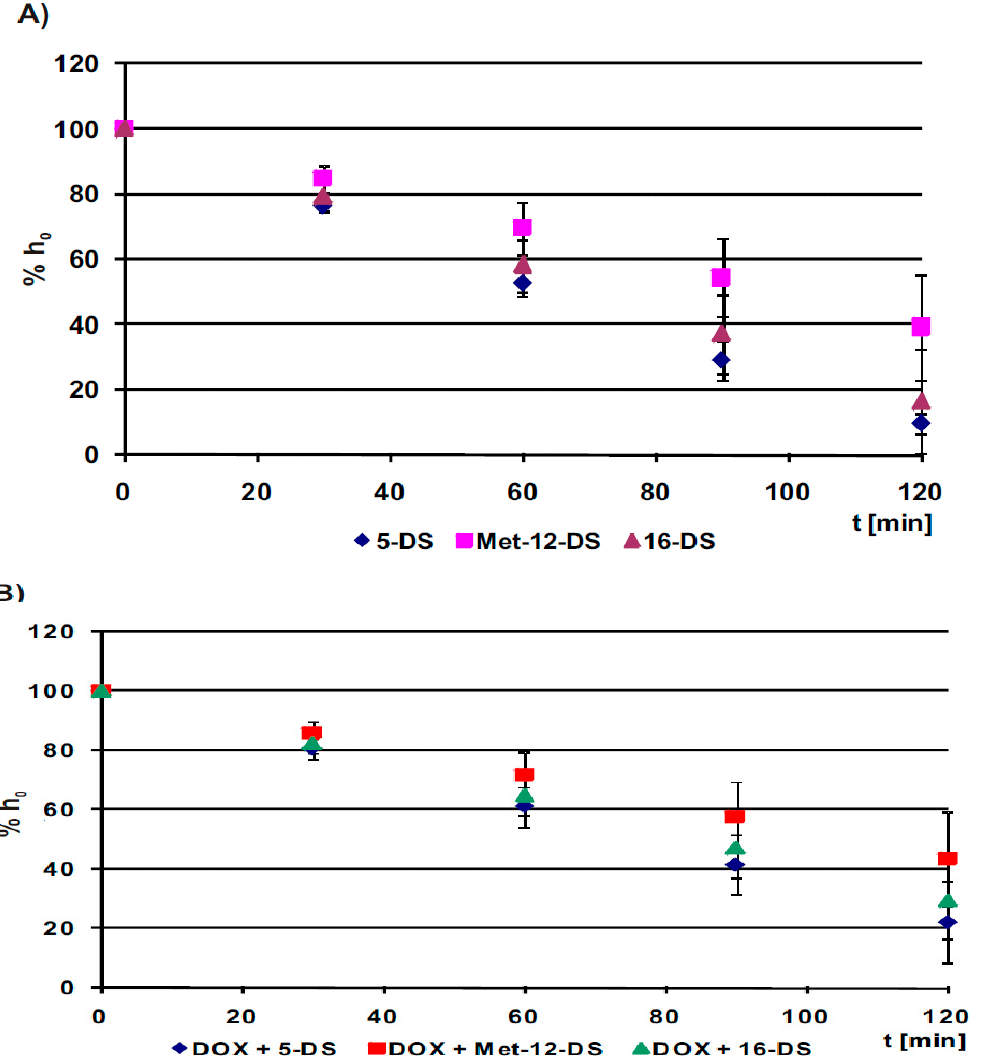
Figure 7. Kinetics of the reduction by B14 fibroblast cells of the doxyl stearate nitroxides (DSs): 5-DS, Met-12-DS, and 16-DS. The data are shown as a percentage of the height of the middle-field line (h 0 ), calculated based on the spectra of the DSs obtained from EPR measurements (Section 4.2.6, Equation (2)). All the data are shown as a mean ± SD of at least three independent experiments. ( A ) Reduction by B14 cells of 5-DS, Met-12-DS, and 16-DS applied alone at 80 µ M final concentration. ( B ) Reduction by B14 cells of 5-DS, Met-12-DS, and 16-DS applied at 80 µ M final concentration together with 1 µ M doxorubicin (DOX). Table 1. ( A ) The rates of reduction (k) in B14 cells of the doxyl stearate nitroxides (5-DS, Met-12-DS, and 16-DS) applied alone at the final concentration of 80 μ M or together with 1 μ M doxorubicin (DOX). The data are presented as means ± SD of at least three independent experiments. ( B ) Half-reduction times in B14 cells of the doxyl stearate nitroxides (5-DS, Met-12-DS, and 16-DS) applied alone at the final concentration of 80 μ M or together with 1 μ M doxorubicin (DOX). The data are presented as means ± SD of at least three independent experiments.